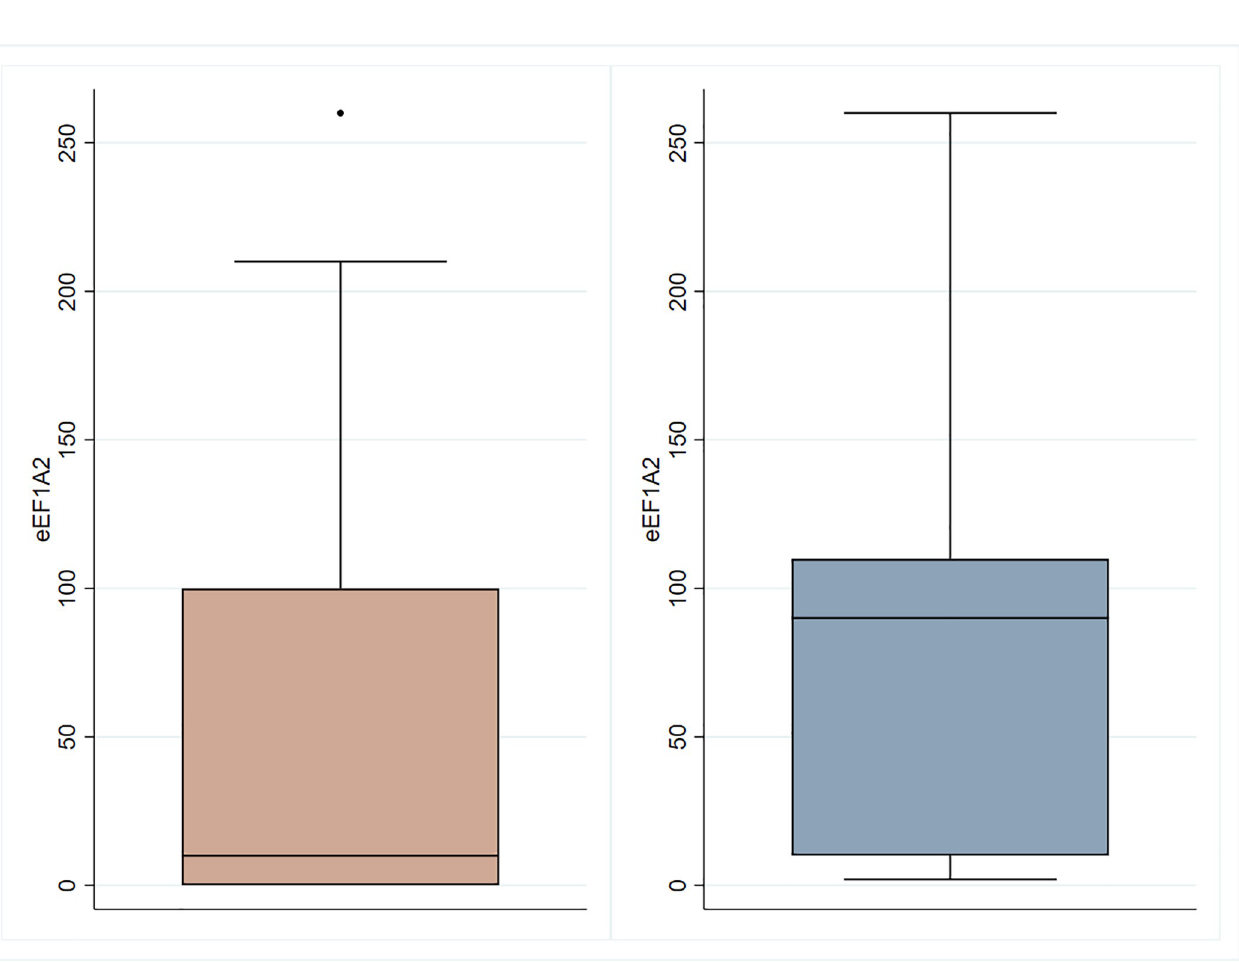
Fig 4. Box plots of eEF1A2 values according to presence (in the left) or exclusion (in the right) of 0 values.